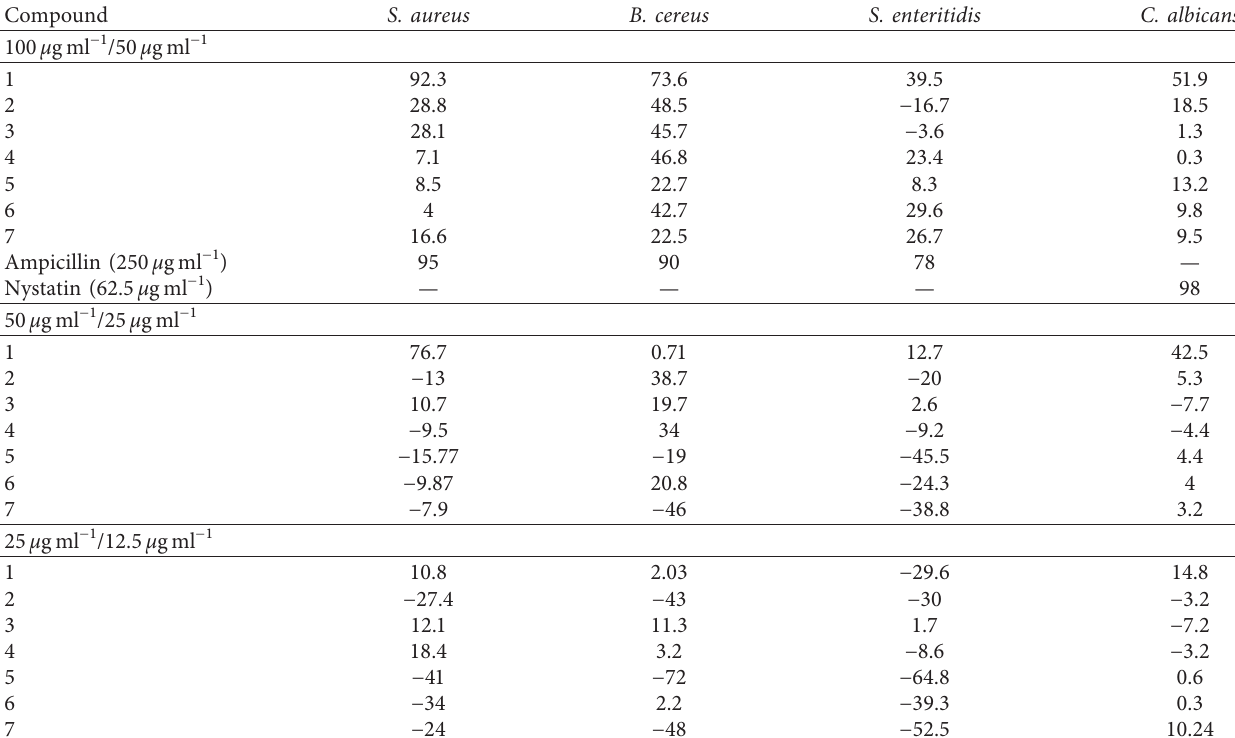
Table 1: Antimicrobial activity of compounds (% inhibition) compared to DMSO.